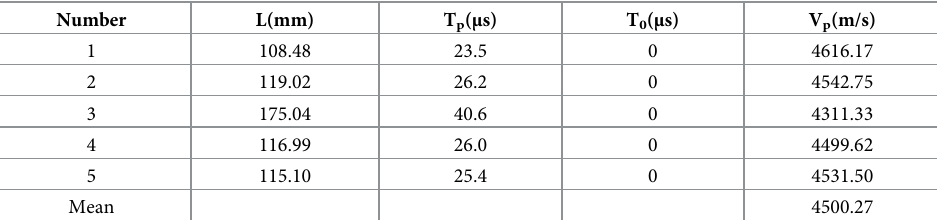
Table 3. Velocity of longitudinal wave of the test